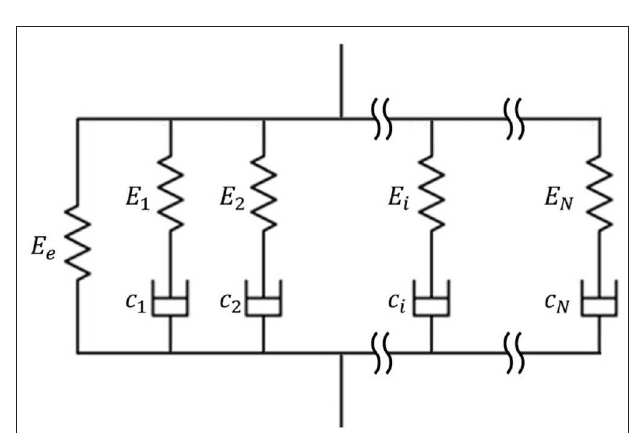
FIGURE 2 | In the generalized Maxwell model, a spring and an arbitrary number of Maxwell bodies are connected in parallel. The standard linear solid model is a special case of the generalized Maxwell model with N =